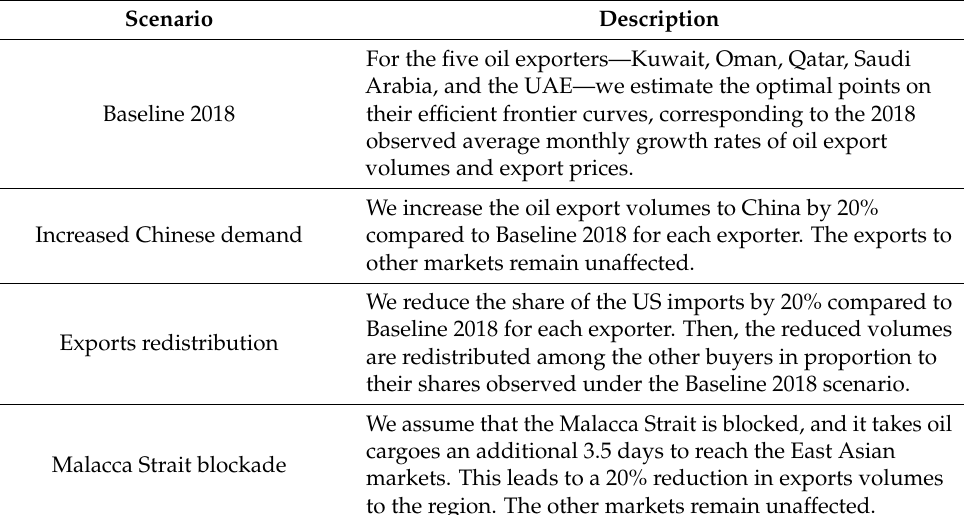
Table 5. Energy security scenarios for oil exports